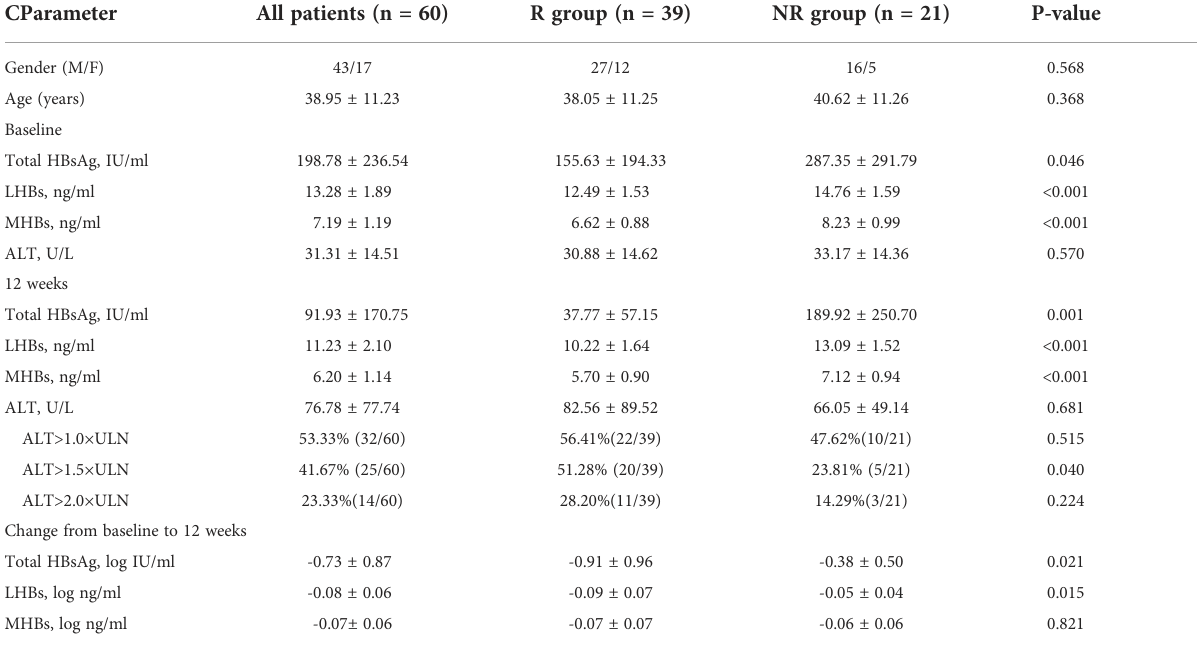
TABLE 1 Characteristics of R and NR groups at baseline and at 12 weeks of treatment.